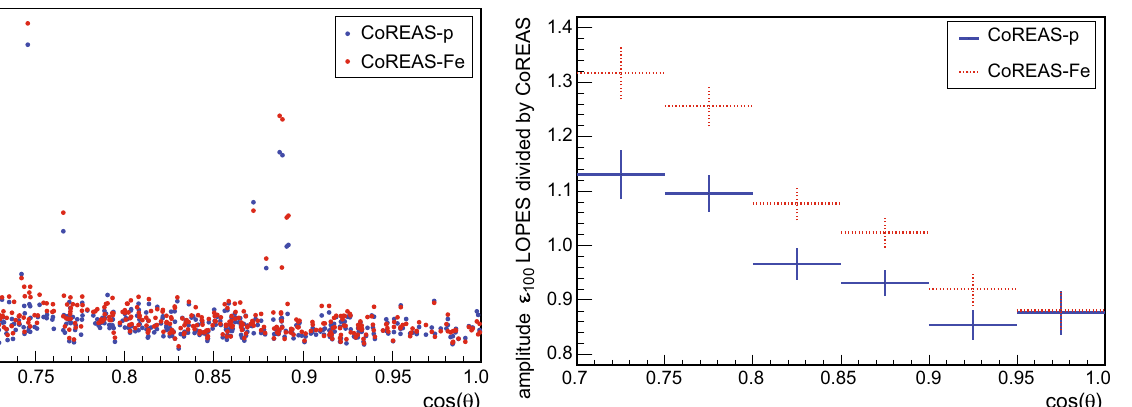
file (right) 11 outliers with ratios larger than 2.5 are excluded (see text for discussion). Deficiencies of the antenna model cannot be excluded and might be the reason for the trend in the ratio versus zenith angle